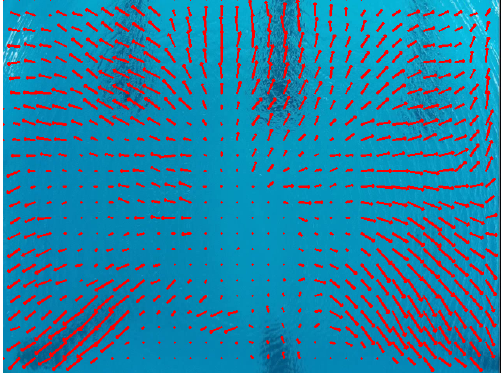
Figure 9. Example of a Optical Flow concept using Farneback algorithm in water (pool).